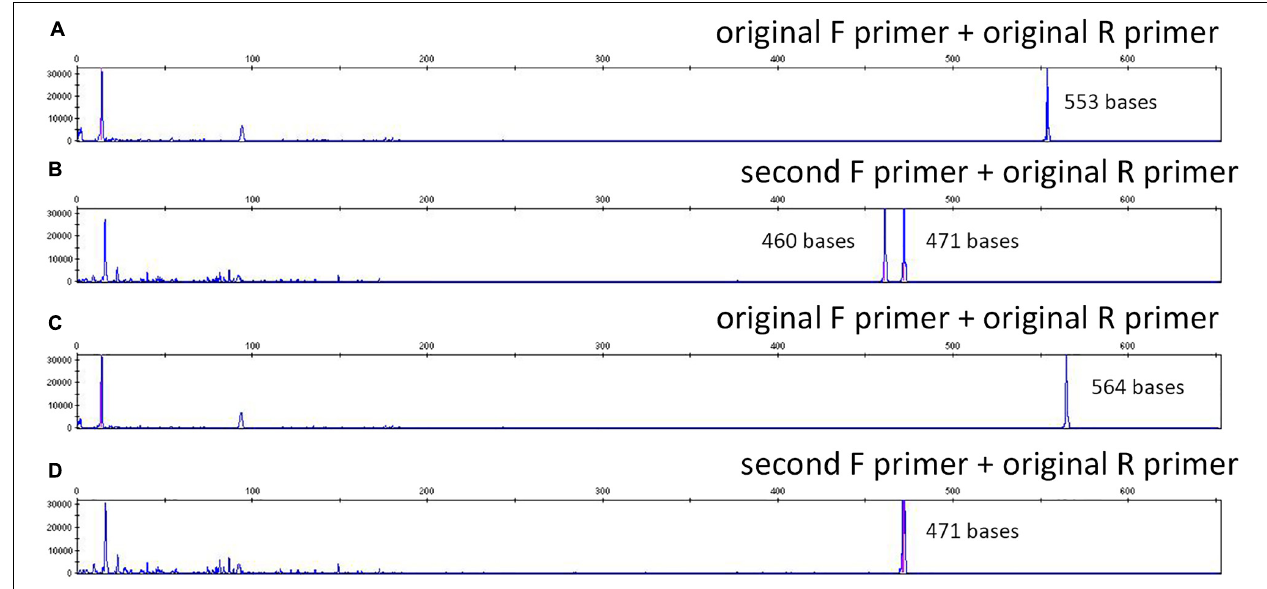
FIGURE 2 | Capillary electrophoresis results using 6-FAM-labeled original and external forward primers for LTBP2 variant amplification (P2): (A) P2, original F primer; (B) P2, second F primer (C) negative control, original F primer; (D) negative control, second F primer. Peaks sizes are reported